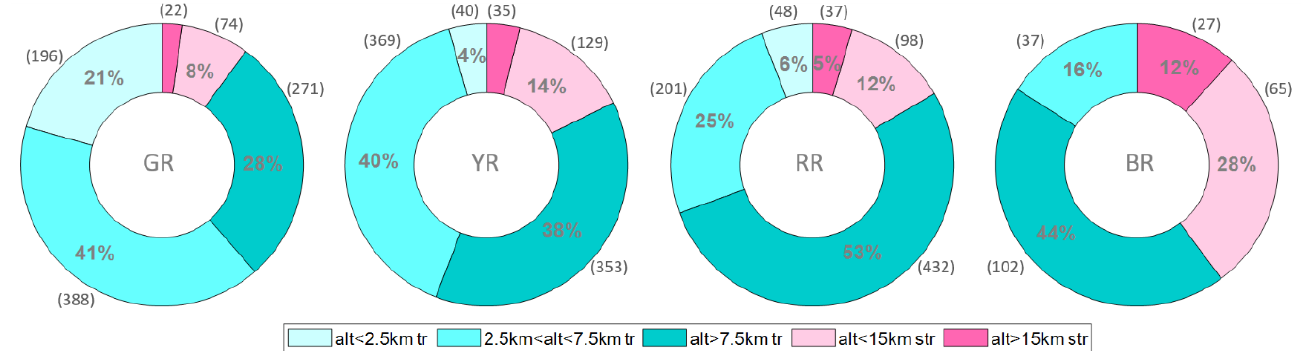
Figure 4. Percentages of BB aerosol layers found in each under-study region (from left to right: GR, YR, RR, and BR) and altitude category (chromatic scale). The numbers shown in the parenthesis next to the percentages refer to the accumulated actual number of observed layers.